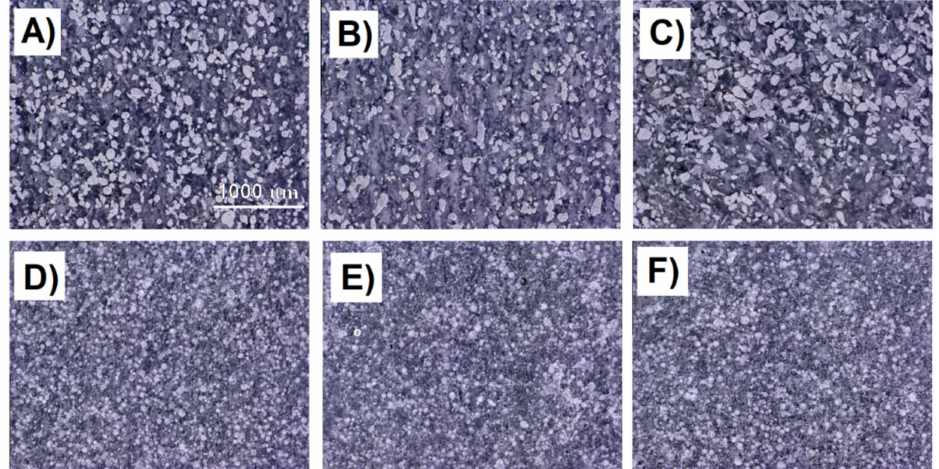
Figure 5. Cross-section of samples observed by confocal microscopy Keyence VHX 6000: